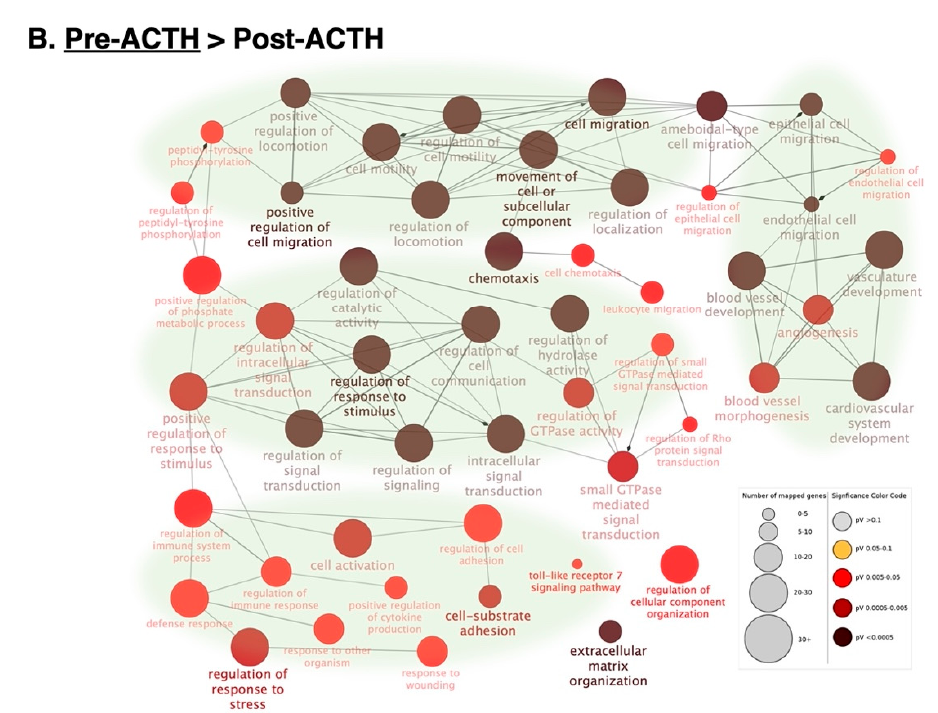
Figure 3. Functional networks as determined by ClueGO (Cytoscape) found in differentially expressed genes (DEGs) affected by ACTH treatment. Overrepresented functional terms are shown for genes upregulated ( A ) and downregulated ( B ) after ACTH treatment. Redundant and/or non-informative terms were removed and obtained networks were rearranged manually. Node size indicates number of mapped genes and level of enhancement is denoted by node color (represented in figure legend). Networks more highly represented after treatment were related to transcription whereas networks related to cell motility, vascularization, cell–cell communication and intracellular signaling, immune signaling and extracellular matrix were more highly represented in samples from the pre-treatment group. The list of representative genes included in different nodes and statistical details are listed in Supplemental File